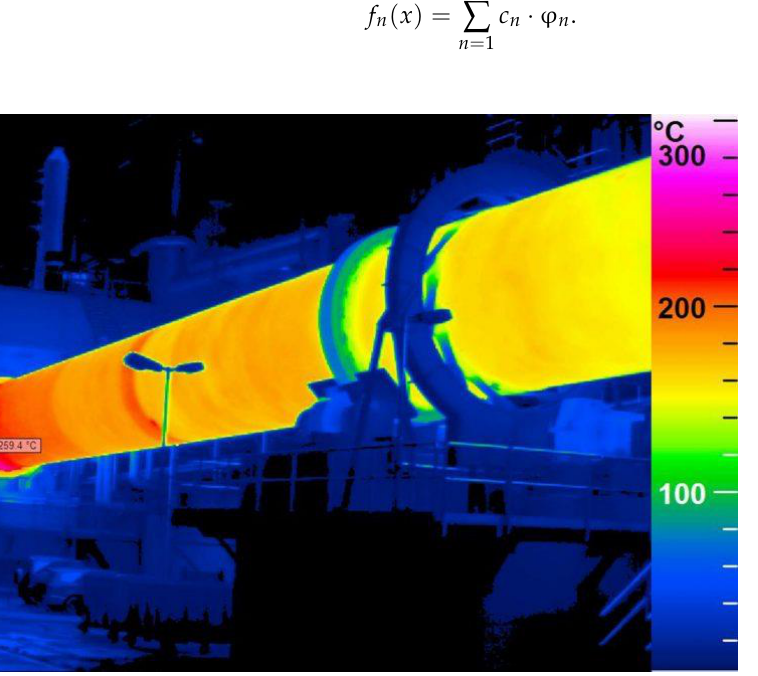
Figure 6. Demonstration of the results of physical modeling using thermal imaging of a rotating furnace according to the authors’ data.